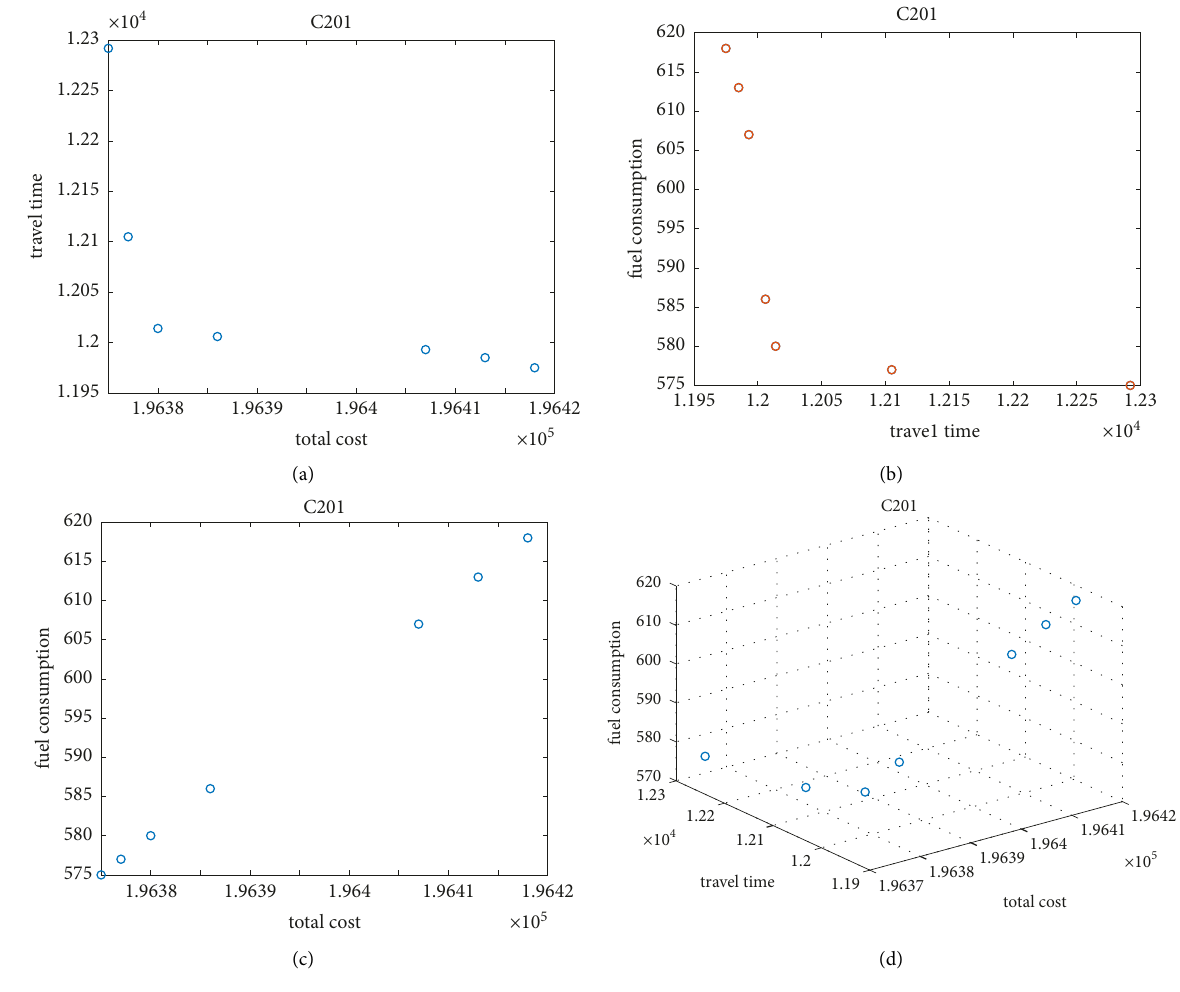
Figure 7: The solutions of